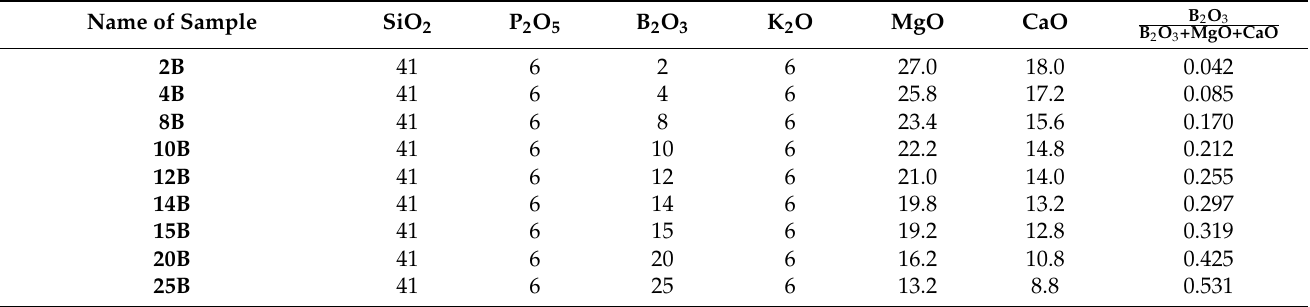
Table 1. Nominal compositions of the analyzed glasses from the SiO 2 –B 2 O 3 –P 2 O 5 –K 2 O–MgO–CaO system